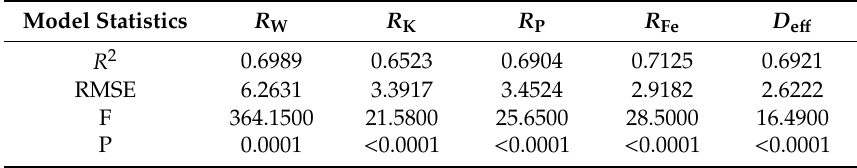
Table 7. Summary of fit (actual vs. predicted) for the five studied responses for the Falcon SB. Model Statistics